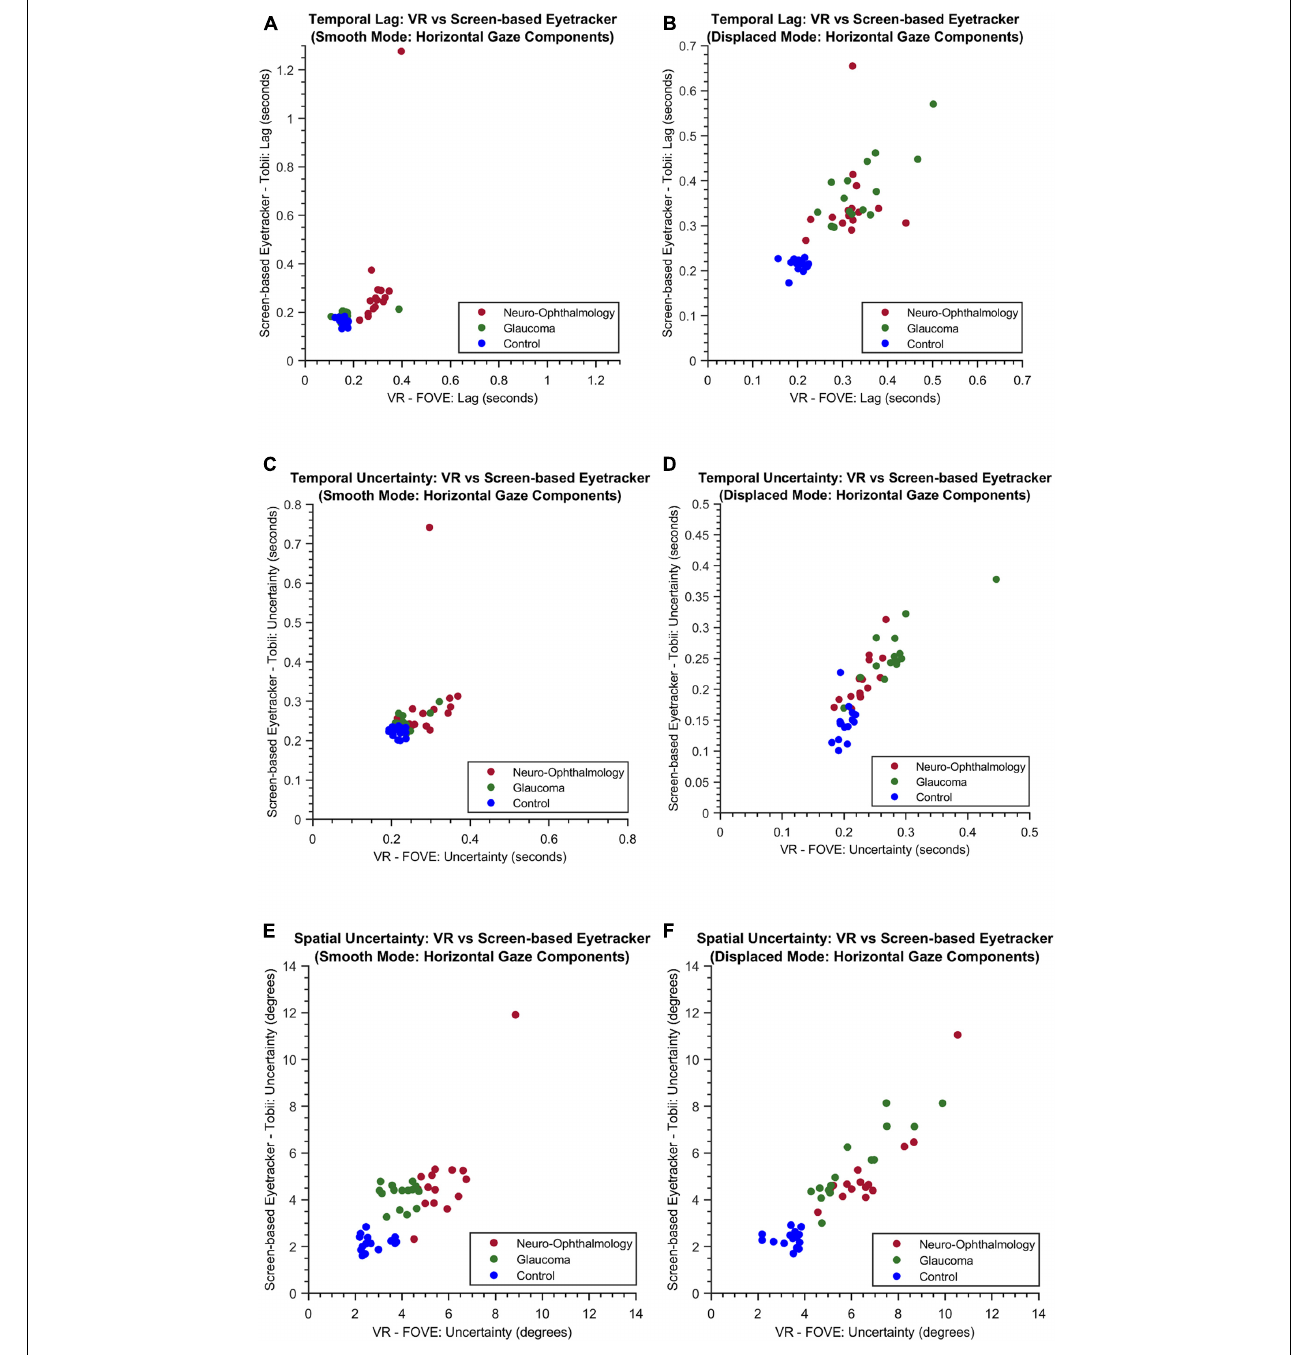
FIGURE 4 | The scatter plots of the temporal lag (A,B) , temporal uncertainty (C,D) and spatial uncertainty (E,F) features obtained for both the experimental modes through VR and the screen-based eye tracker. For simplicity, only the horizontal components are shown.